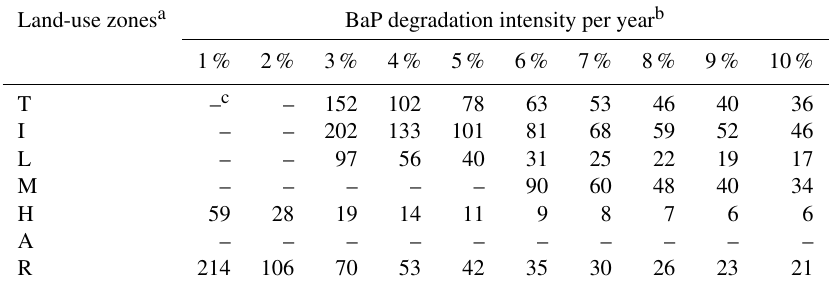
Table 3. The number of years required to lower the BaP content in the soils of the EAD to the MPC (20ngg − 1 ) at the existing fallout levels. Land-use zones